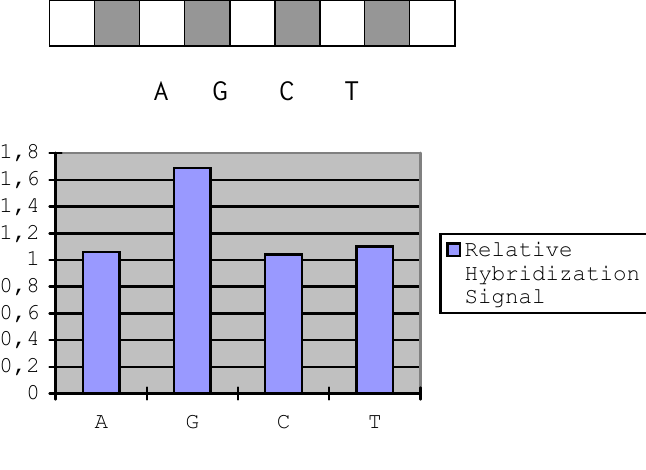
Figure 3. Schematic drawing of in situ synthesis